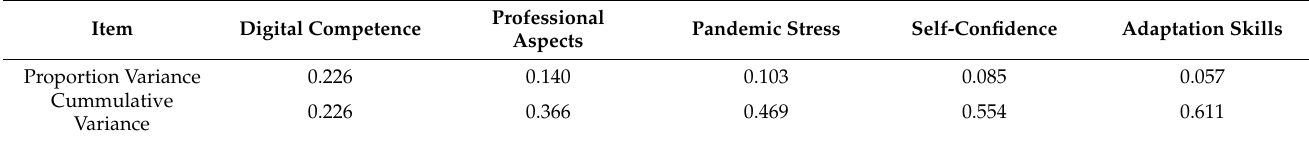
Table 3. Cumulative proportion of explained variance of the principal component analysis.